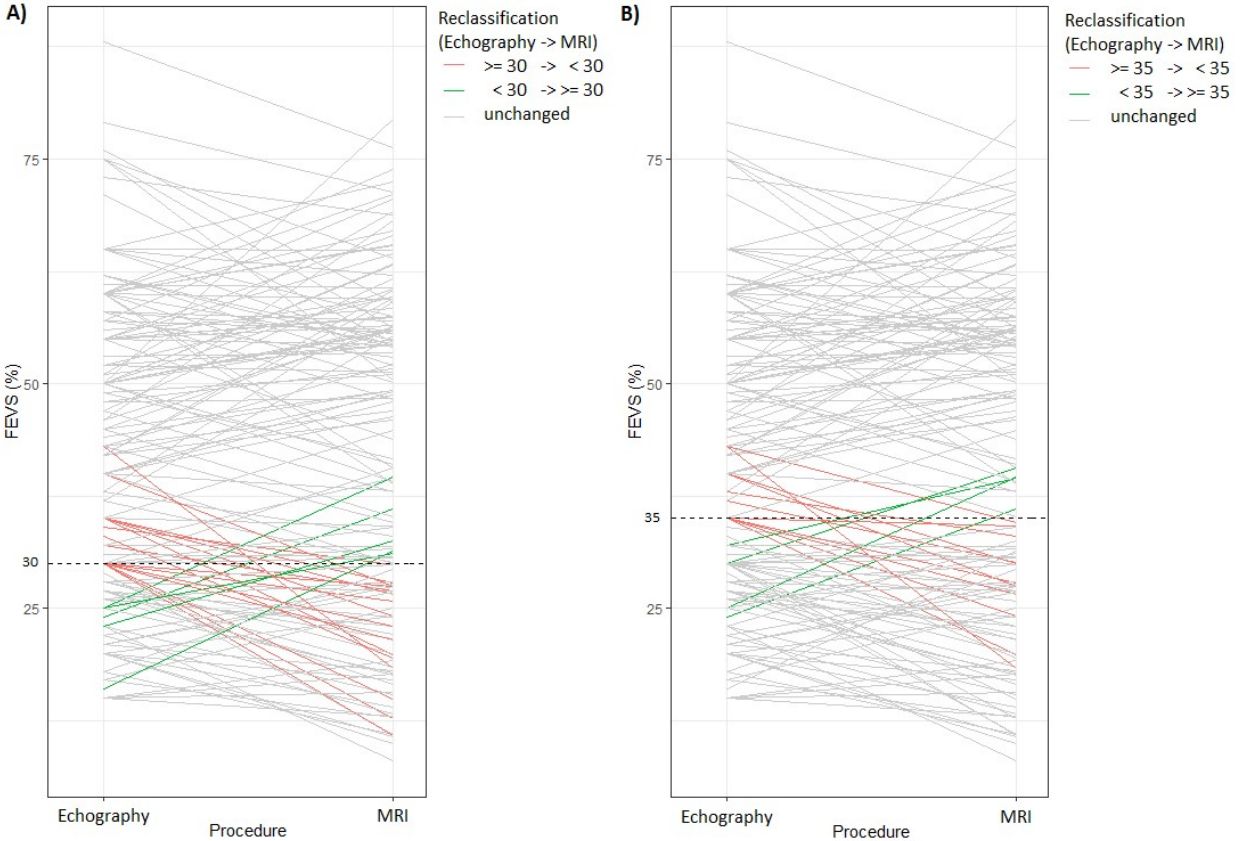
Figure 4. Reclassification of ejection fractions from echocardiography measurements to CMR measurements, for two thresholds used for implementing ICD therapy. ( A ) Patients reclassified for a 30% FEVS threshold, ( B ) Patients reclassified for a 35% FEVS threshold